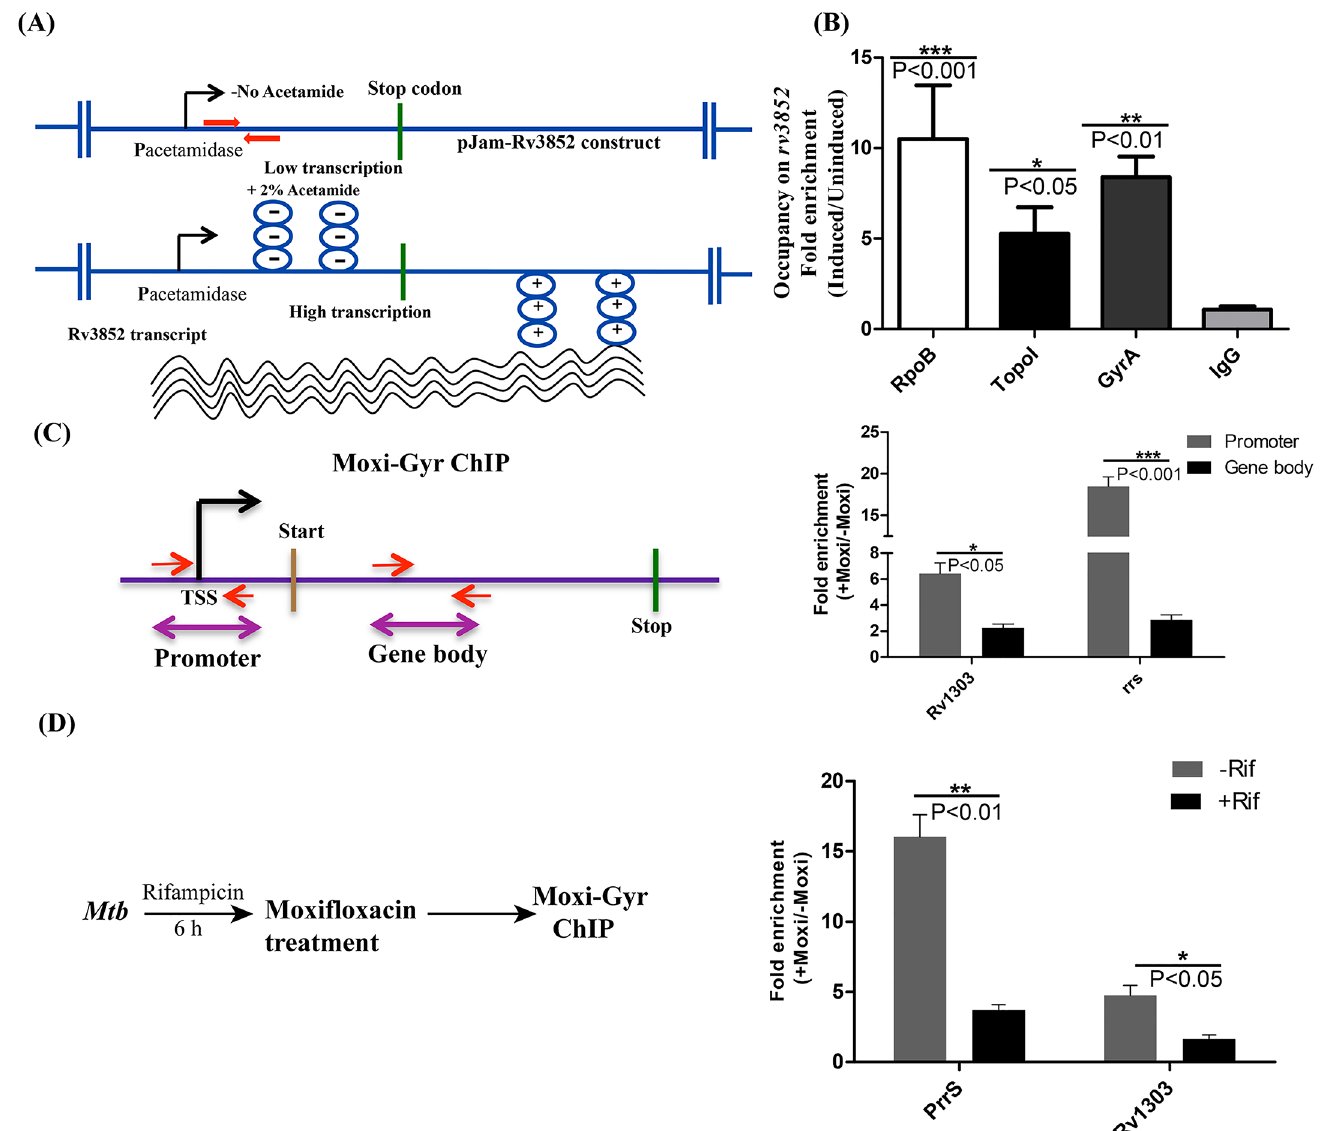
Fig 4. Transcription induction recruits topoisomerasesto TU. Determination of the occupancyof RNAP, Topo I and DNA gyrase on activated TU. (A) Schematic of the experimental set up. Inductionof transcription introducessupercoilson the template whichrecruits topoisomerases. Construct pJam-Rv3852was electroporated into M . smegmatis and the transformants were grownup to the exponentialphase.Cultures wereinducedwith acetamide for 6 h to activate the transcription of rv3852 clonedunder the acetamidasepromoter. Arrows (red) indicatethe positionof primers for the amplification of target region (B) Induced(I) and uninduced(UI) cultures were processed for ChIP and enrichmentof RNAP, Topo I and DNA gyrase was monitored by the qPCR using rv3852 specificprimers. UnrelatedIgG antibodywas usedas a negativecontrol. (C) Depictionof the architecture of TU and the positionsof the primers usedfor monitoringthe gyrase bindingon promoterregion(P) and genebody of Rv1303 and rrS TUs. Mtb cells were treated with Moxifloxacin (Moxi) and gyrase-DNA clevagecomplexes aroundpromoterand genebody were detectedby qPCR. (D) Effect of transcription inhibition on topoisomerase activity. Mtb cells were treatedwith or withoutRifampicin(Rif) followedby treatment with Moxifloxacinto inducegyrase-DNA cleavagecomplexformation.Promoter regionsof Rv1303 and rrS were monitored for the formation of gyrase-DNA cleavagecomplexin the presence andabsenceof Rif. Error bars representthe SD obtained from three independent experiments. Significance of the observationswas assessed by applying unpaired t-test ( * = P < 0.05; *** = P < 0.001; ** < P < 0.01;ns = not significant).